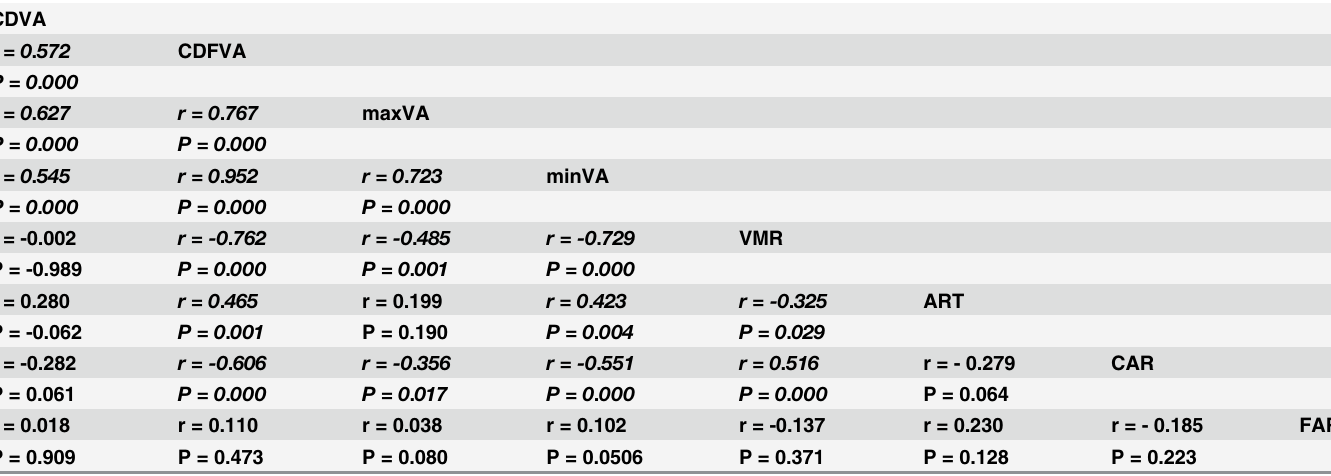
Table 3. Spearman Rank Correlation of the CDVA, Parameters of the CDFVA, and the VFIT-EV with Each Other (n = 45) a